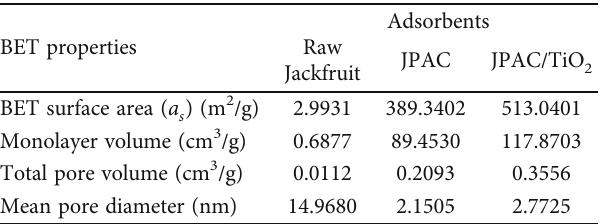
Figure 5: N adsorption-desorption isotherms of JPAC and JPAC/TiO 2 Table 2: Physical properties of activated carbon from jackfruit peel using BET analysis.